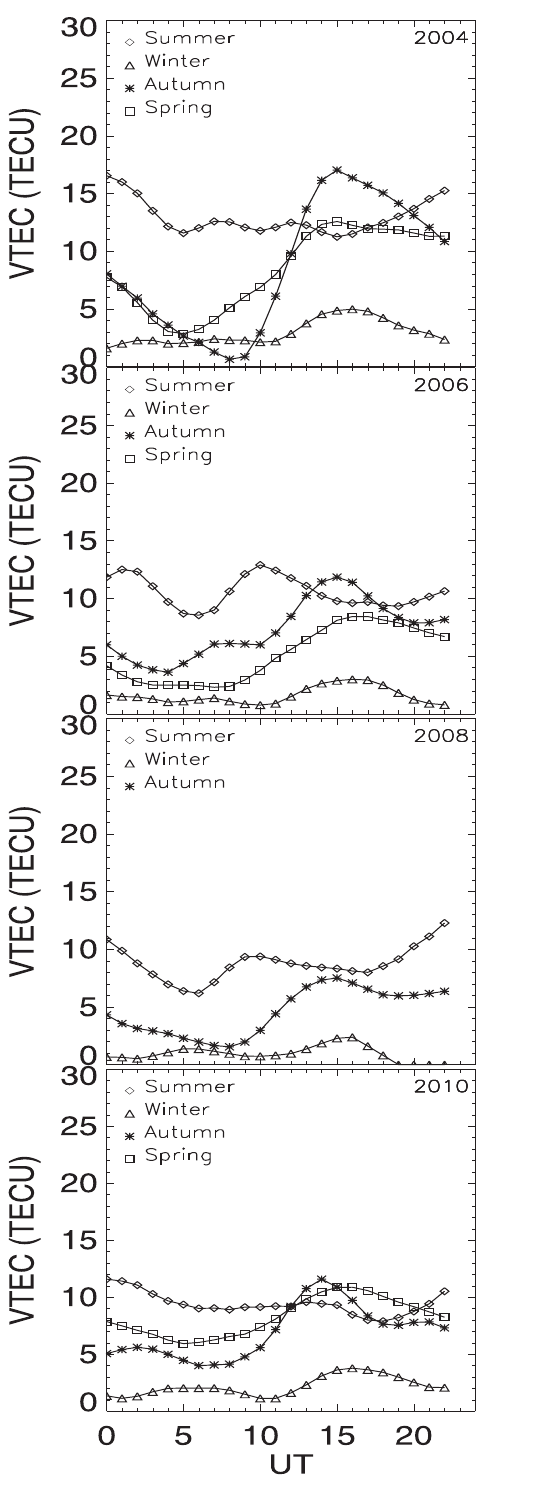
Figure 4. Seasonal variability of the VTEC for each year from 2004 to 2011. Each curve refers to the mean diurnal variation that is repre- sentative of each season, as observed at EACF